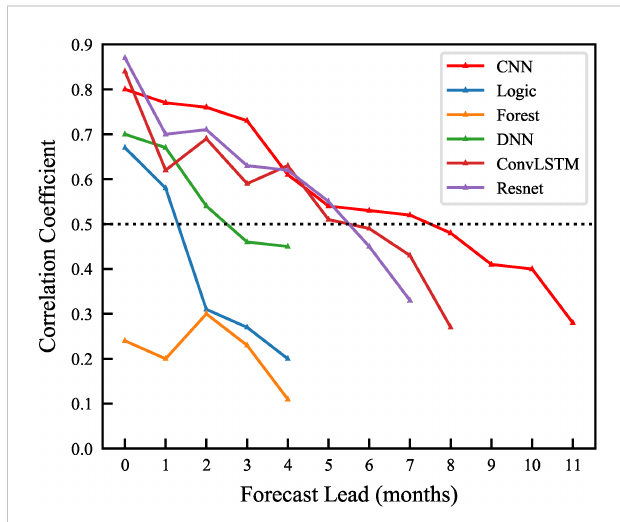
FIGURE 9 Comparison of actual ITF and predicted ITF transport of SODA using various